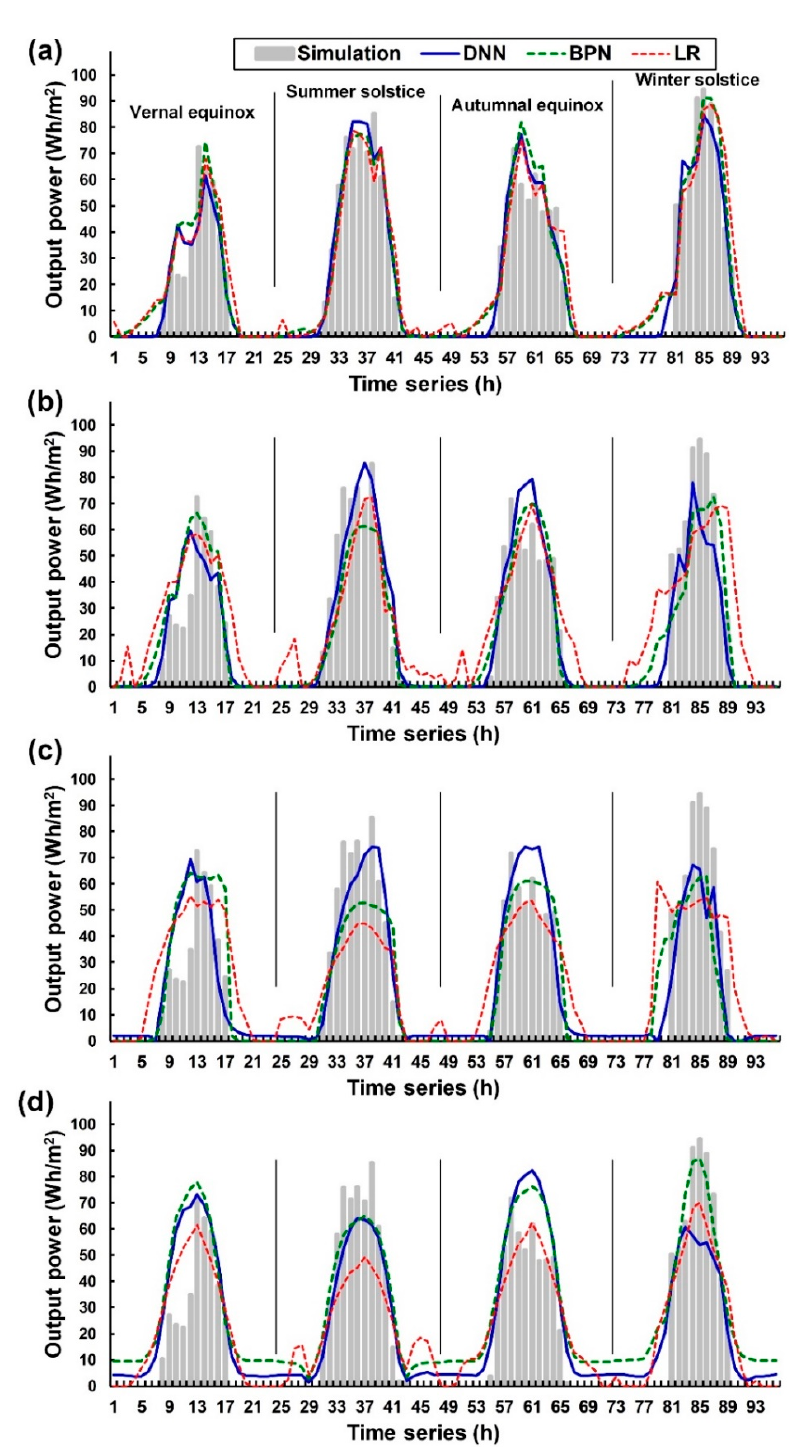
Figure 9. Simulation and predicted values on the hourly power output of BP3125 at spring and autumn equinoxes and summer and winter solstices in 2016 at lead times of ( a ) 1; ( b ) 3; ( c ) 6 and ( d ) 12 h.